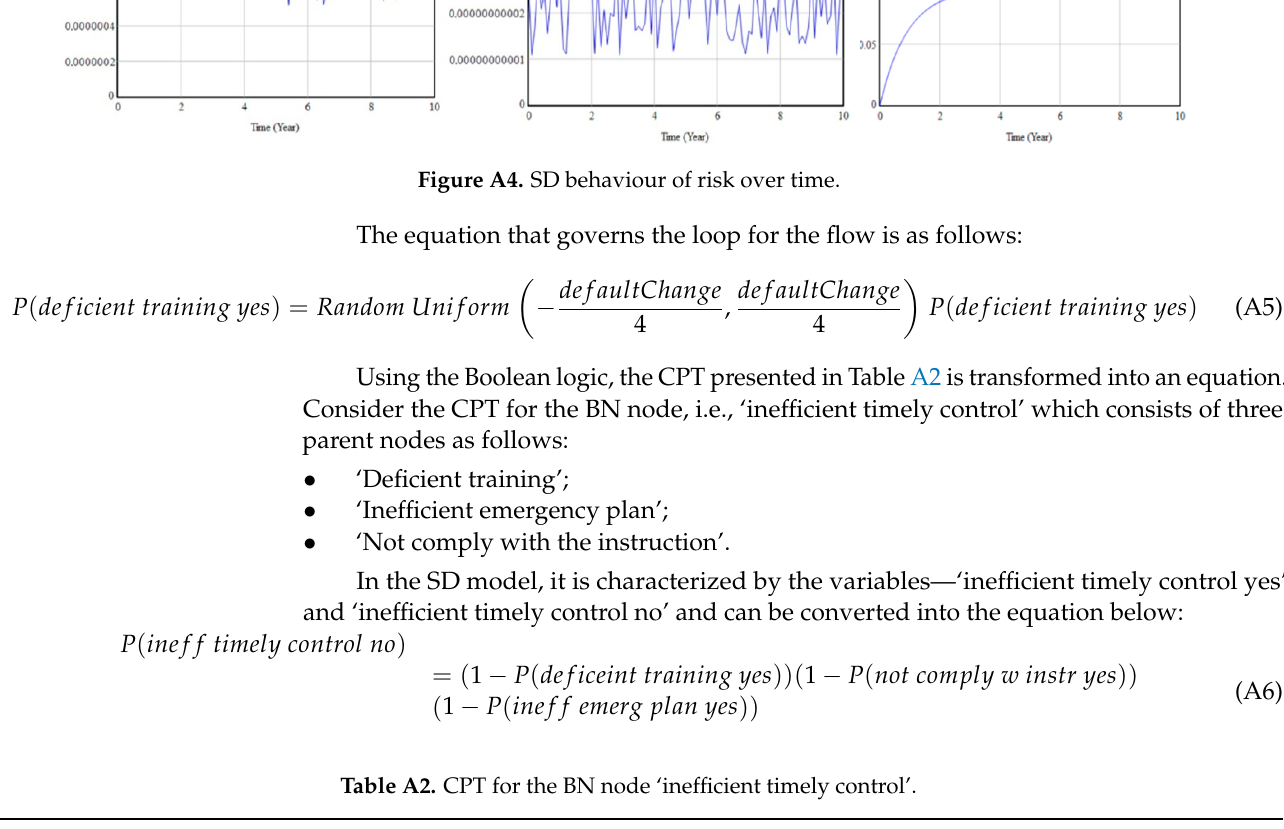
Table A2. CPT for the BN node ‘inefficient timely control’.